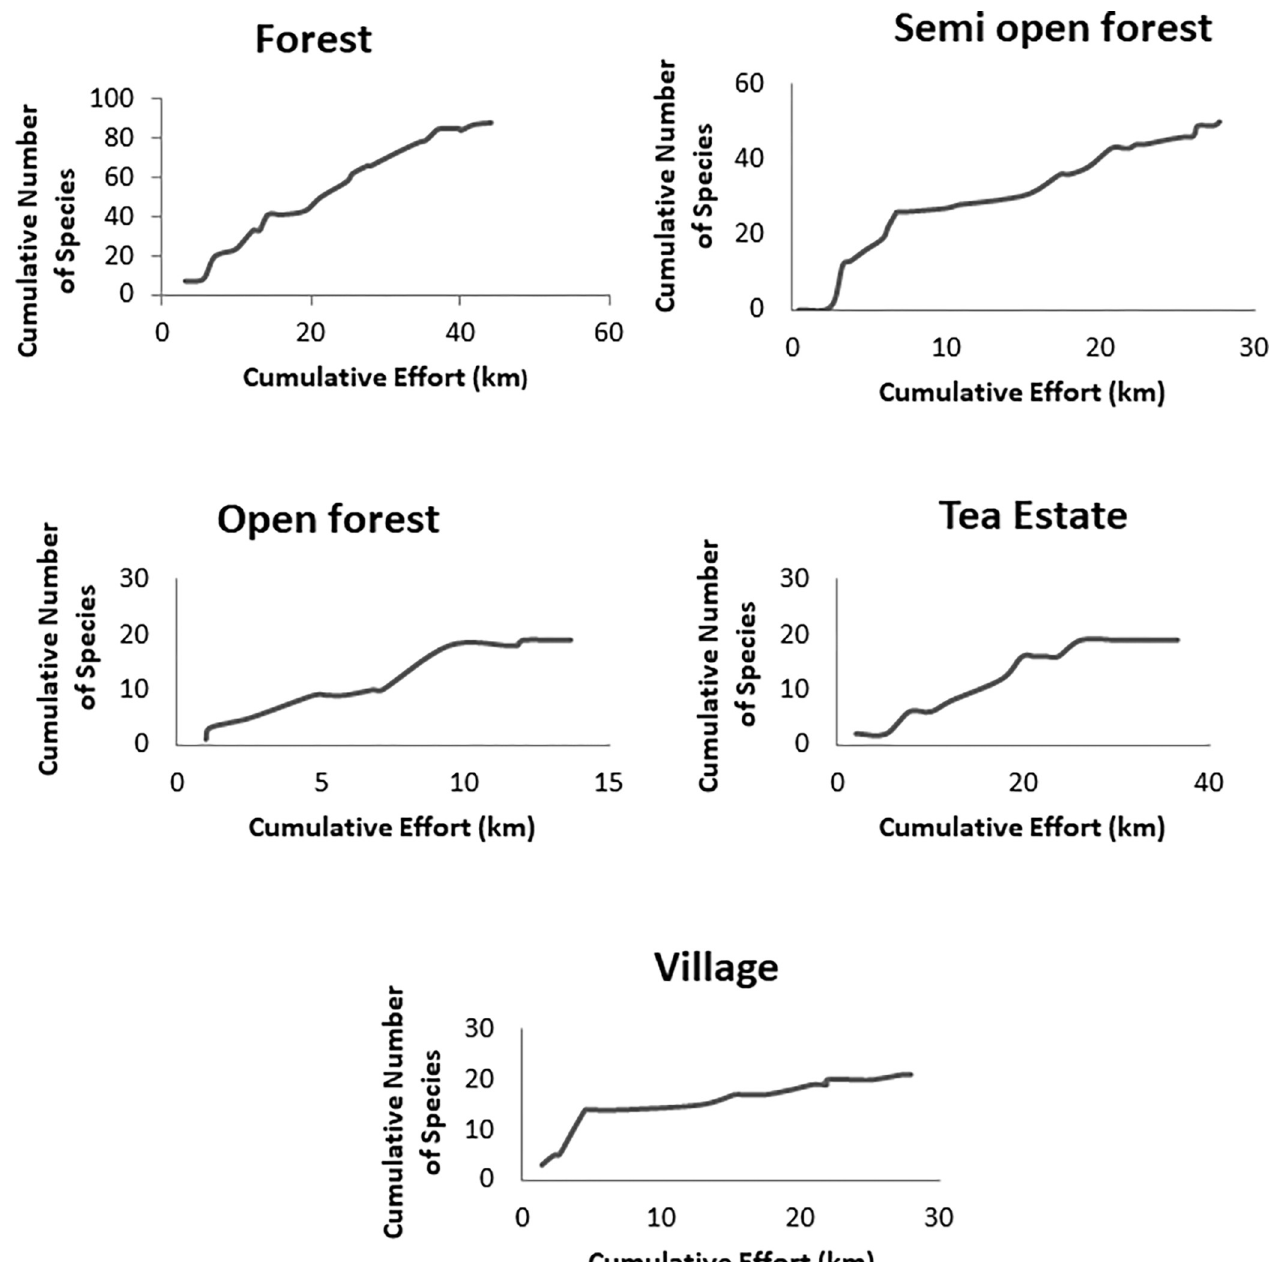
Fig 2. Species accumulation curve for forage use by Asian elephant in forest, semi-open forest, open forest, tea estate, and